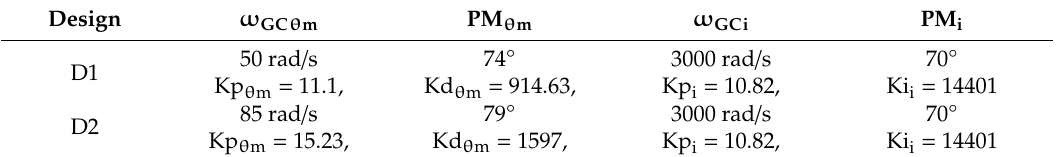
Table 1. D1 and D2 position controller designs for the IM machine.